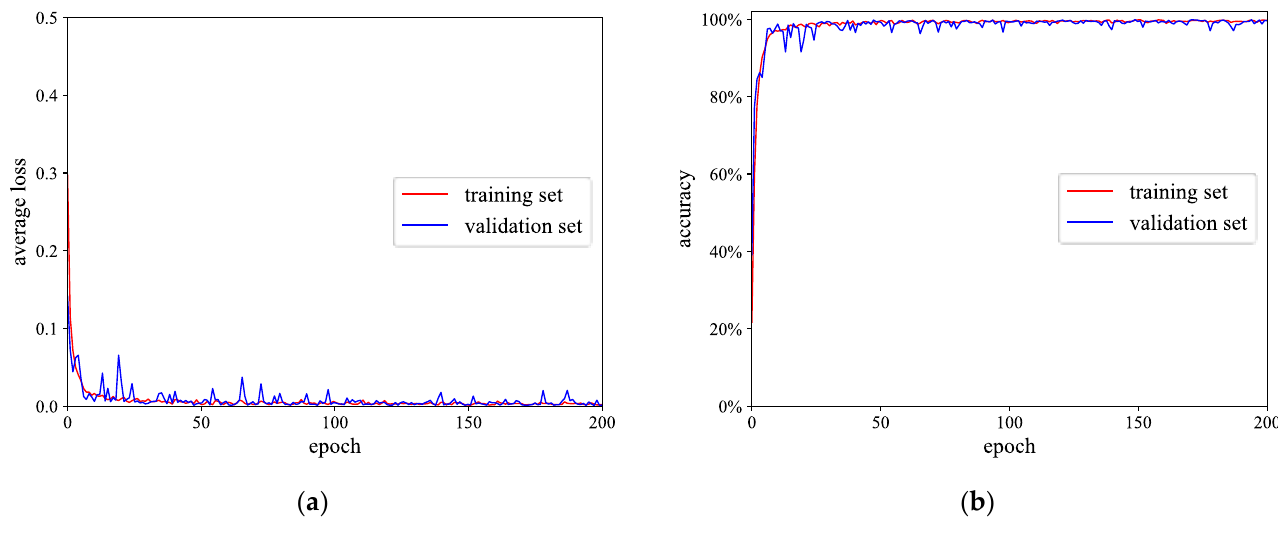
Figure 16. The training process of the CSAM-MSCNN: ( a ) Loss function curve; ( b ) accuracy curve. Ten parallel experiments were conducted to avoid specificity and chance, and the experimental results are shown in Tables 10 and 11. The results when comparing the method in this paper with the CBAM-MSCNN and the rest of the models are shown in Figure 17. Table 10. Parallel experimental results of the CSAM-MSCNN.